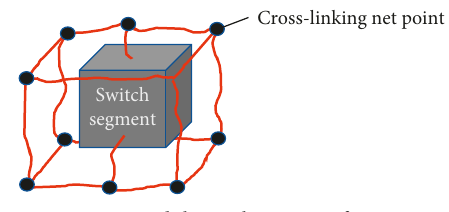
Figure 1: Modular architecture of an SMP.